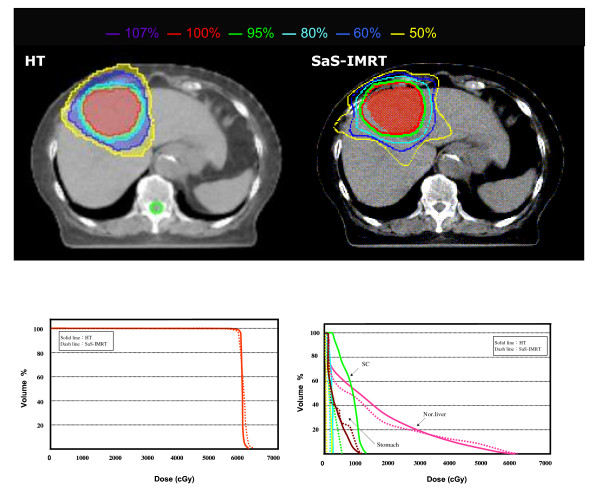
The comparison of isodose distributions of planned target volume (PTV) and organs at risk (OARs) in an axial plane for one patient in group 1 using the helical tomotherapy (HT) planning system versus step-and-shoot intensity-modulated radiotherapy (SaS-IMRT). DVH: Dose volume histograms; PTV = Planning target volume; OAR = Organ at risk